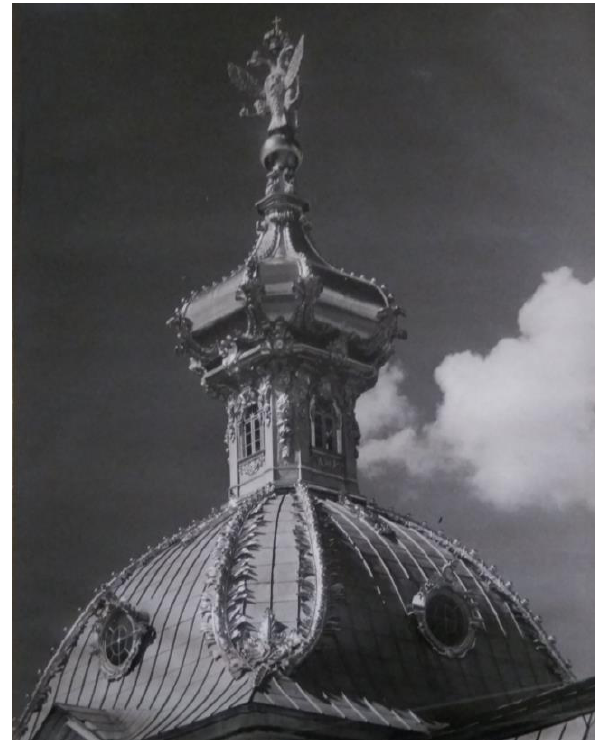
Figure 5. The cupola and the dome of the Western part of the Grand Palace after restoration © Boris Lobovikov